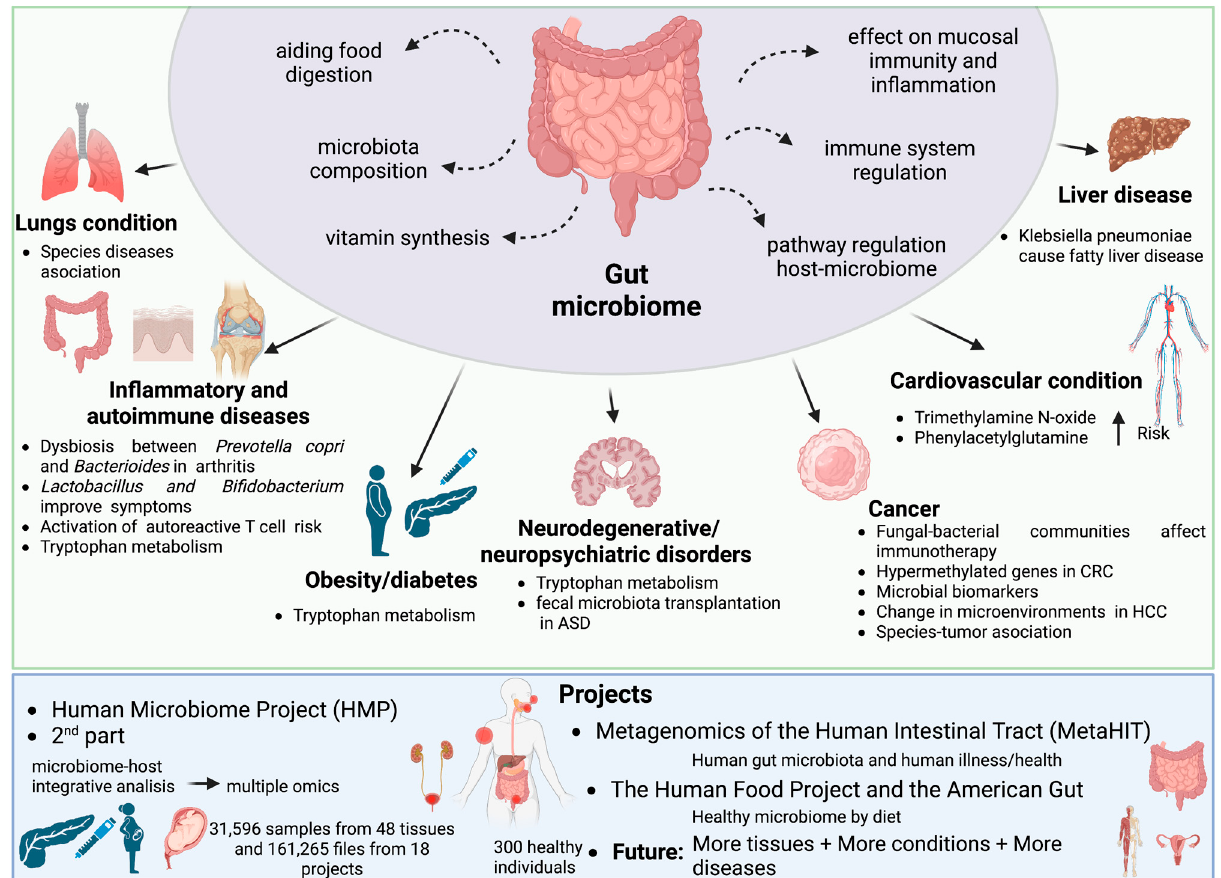
Figure 1. Effects of the gut microbiome on diseases and international metagenomics and meta- transcriptomics consortia and projects . We collected examples for different diseases regarding a variety of organs and the implications of microorganisms for prognosis and treatment, most of them derived from gut microbiome. For instance, some species has been linked to lung disease [36,37]. Inflammatory and immune diseases have a strong relationship with microorganisms [38–44], as well as diabetes [44], neurodegenerative and neuropsychiatric disorders [44–46], cancer [47–50], cardiovascular susceptibility [51,52] and liver disease [53]. There are several consortia whose aim is to obtain microorganism information from different types of samples, as de Human